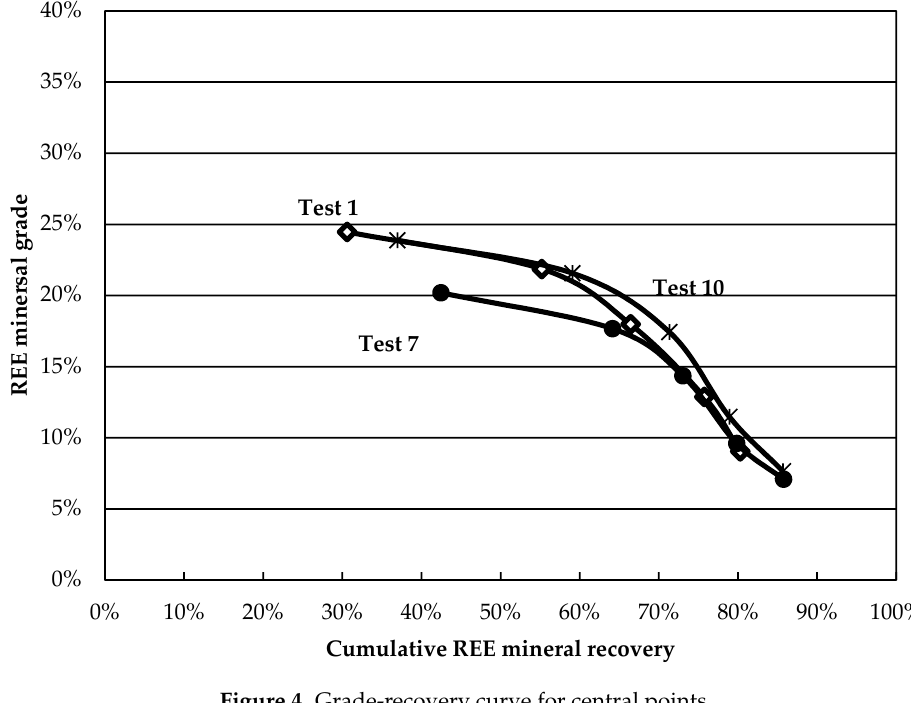
Minerals 2019 , 9 , x FOR PEER REVIEW Figure 4. Grade-recovery curve for central points. Figure 4. Grade-recovery curve for central points.